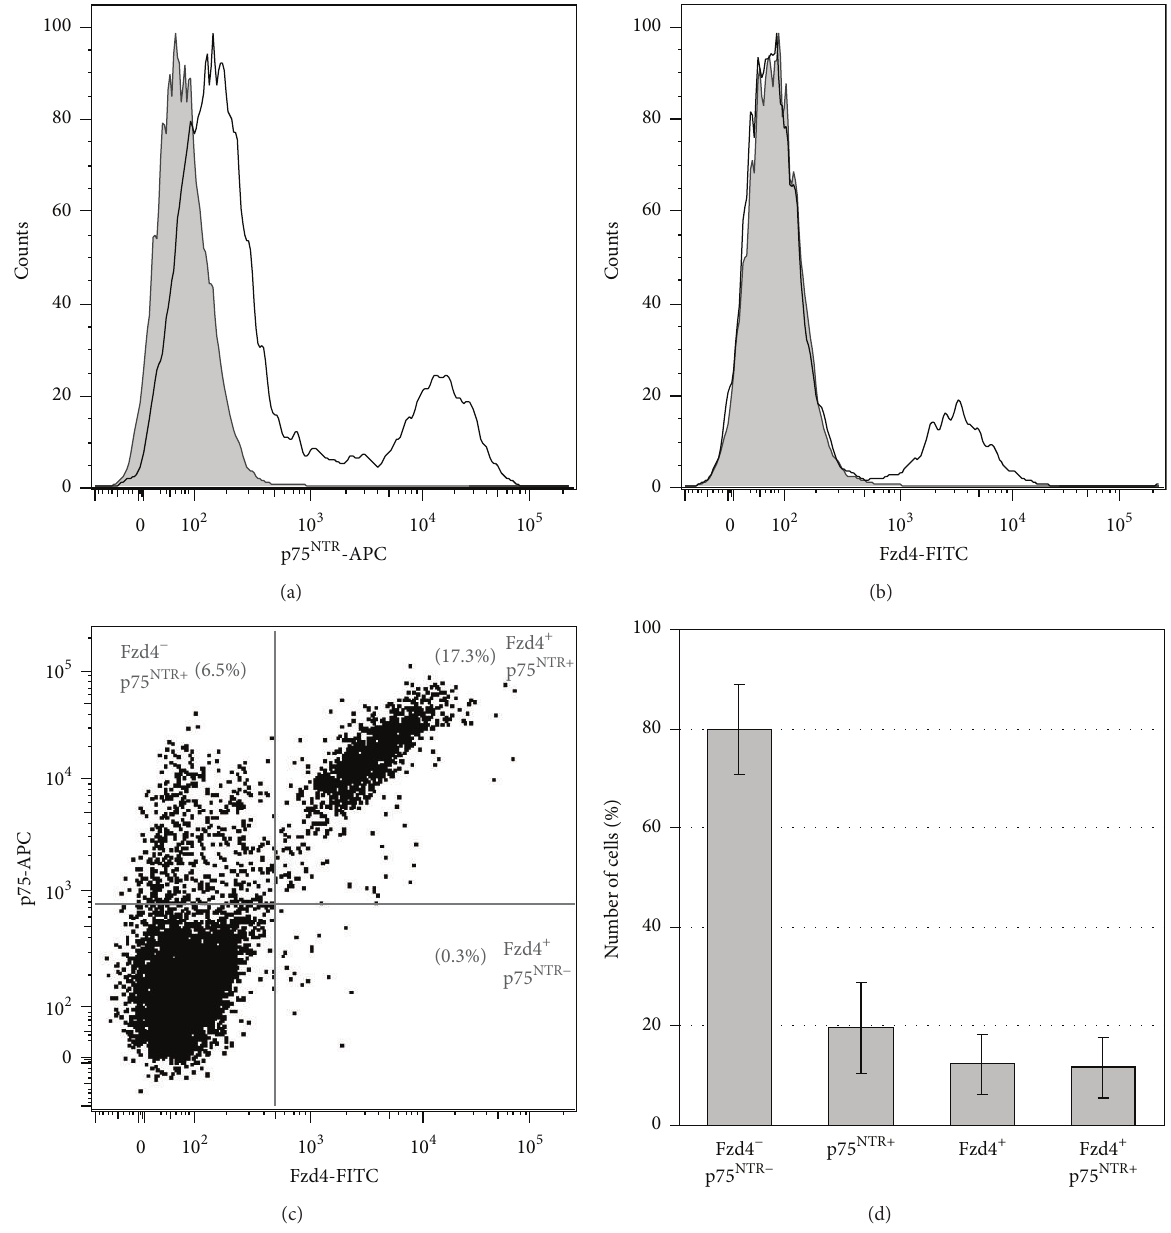
Figure 5: A distinct frizzled-4 positive cell population is observed by flow cytometry. Flow cytometry analysis of p 75 NTR and frizzled-4 (Fzd4) expressiononcellsisolatedfromtunicamuscularis(samplenumbers3,5–9).(a,b)Histogramsforp 75 NTR -APCandFzd4-FITCincomparison to respective isotype controls. The isotype control staining is shown as gray filled histogram. (c) Representative dot plot of p 75 NTR -APC and Fzd4-FITC costained cells. Numbers indicate the percentage of stained cells in each gate. (d) Quantification of the percentages of unstained, p 75 NTR Fzd4 positive, and p 75 NTR /Fzd4 costained cells from six independent experiments. Data are expressed as mean percentage ± SD of the total cell